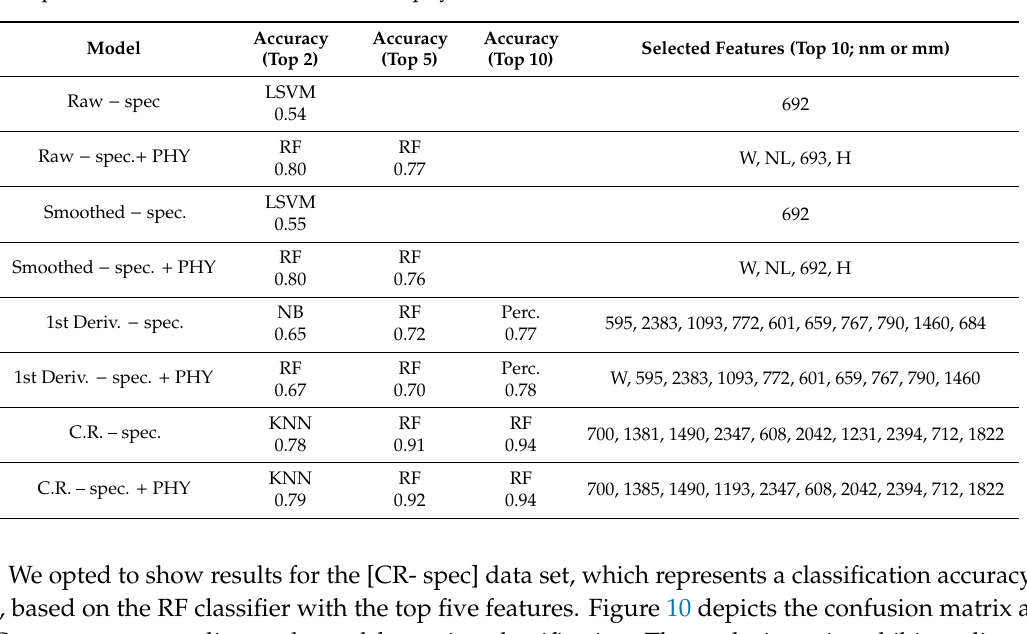
Table 6. Results for growth stage classification—pod formation. Note how continuum-removed model outperform others without the use of biophysical features.